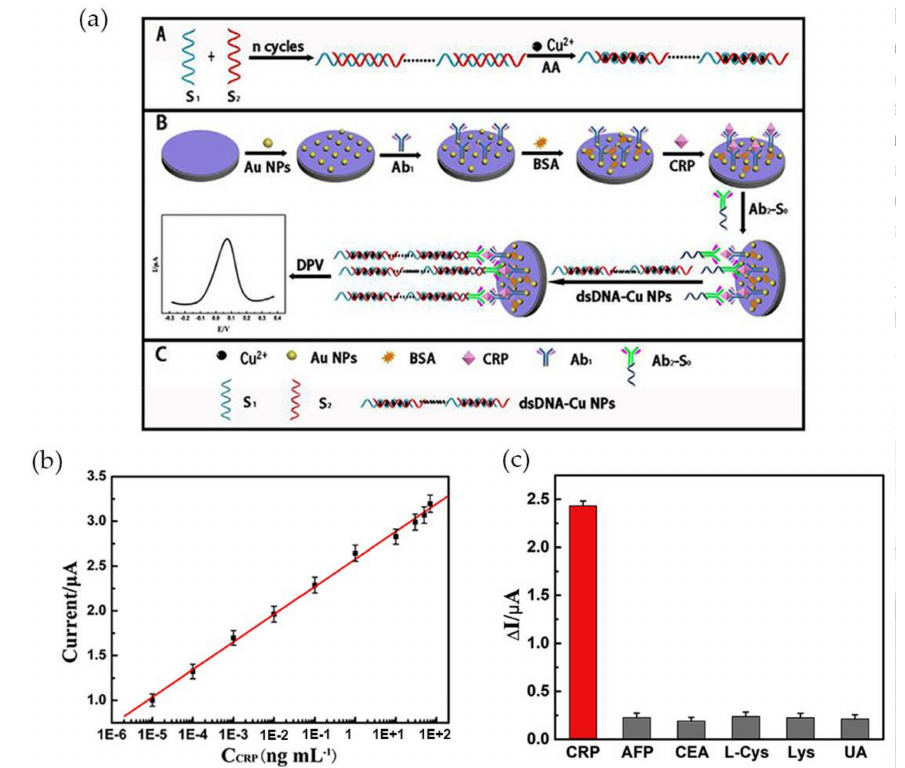
Figure 6. ( a ) Schematic illustration of the preparation of the electrochemical immunosensor; ( b ) Calibration curve of peak current using variable CRP concentrations and 10% of serum; ( c ) Selectivity of CRP testing sensor for 0.1 ng · mL − 1 CRP and 10 ng · mL − 1 of the interfering components alpha-fetoprotein (AFP), carcinoembryonic antigen (CEA), L -Cystein ( L -Cys), lysine and uric acid (UA), tested individually. Reproduced with permission from ref. [74]. Copyright Elsevier Inc.,